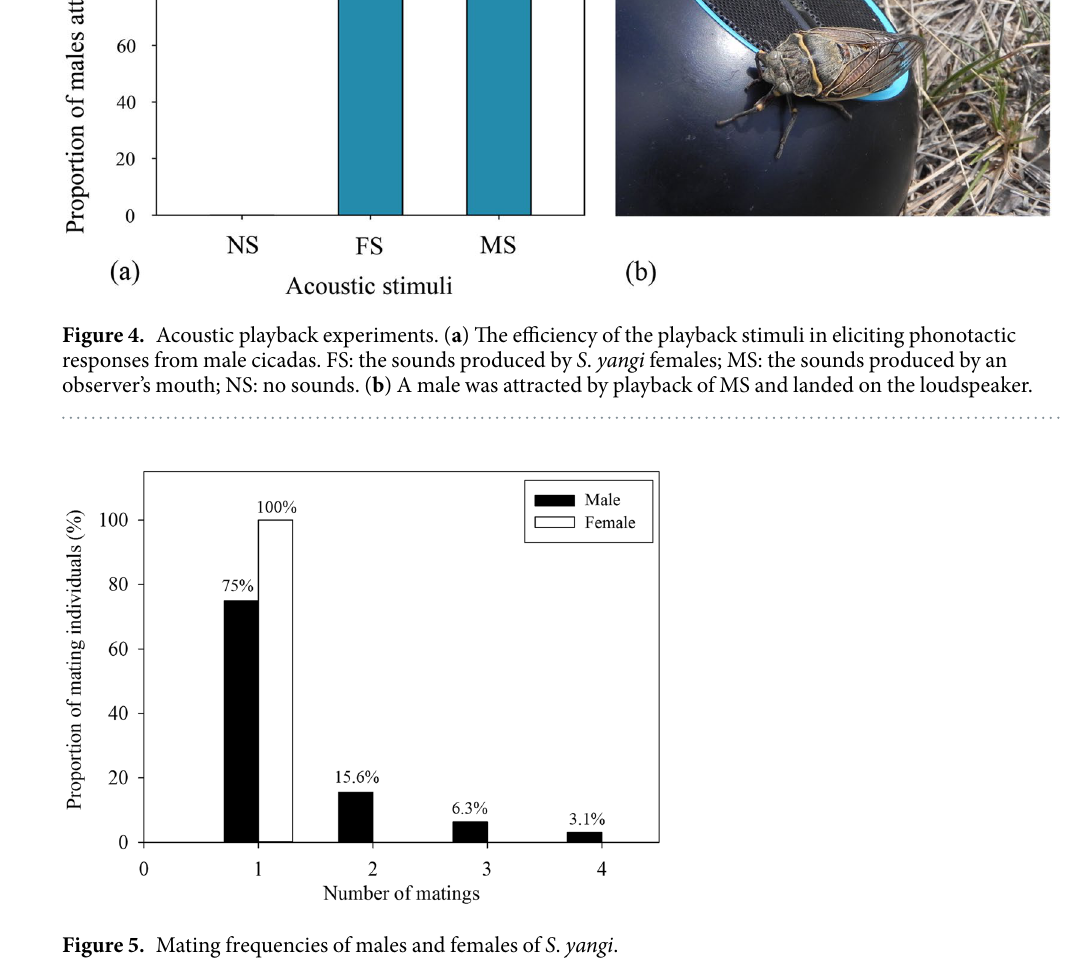
Figure 5. Mating frequencies of males and females of S . yangi